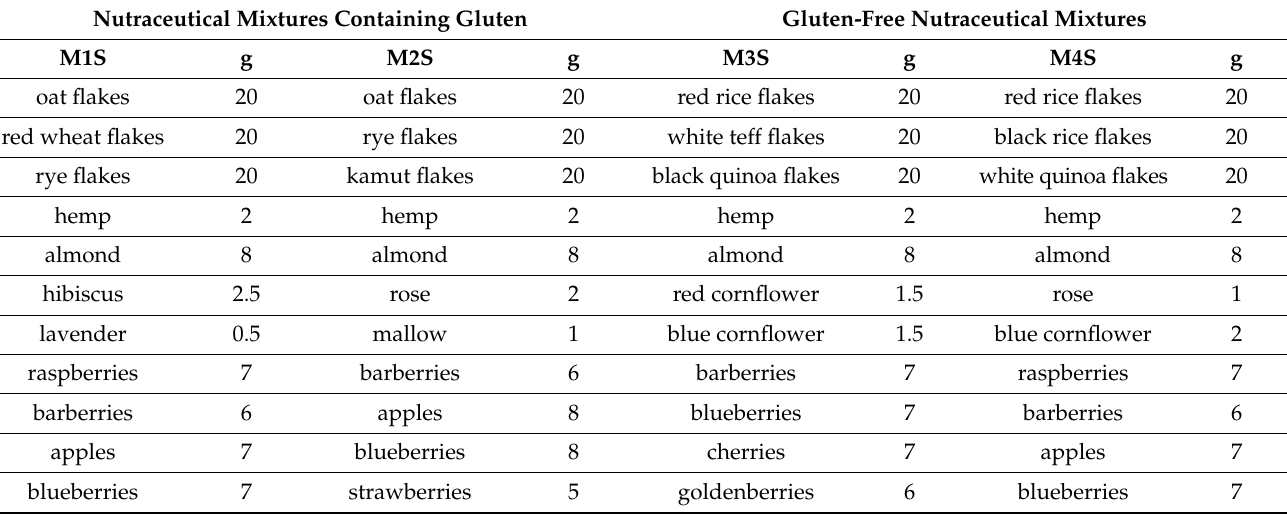
Table 1. The specific composition of the nutraceutical mixtures with edible flowers. Nutraceutical Mixtures Containing